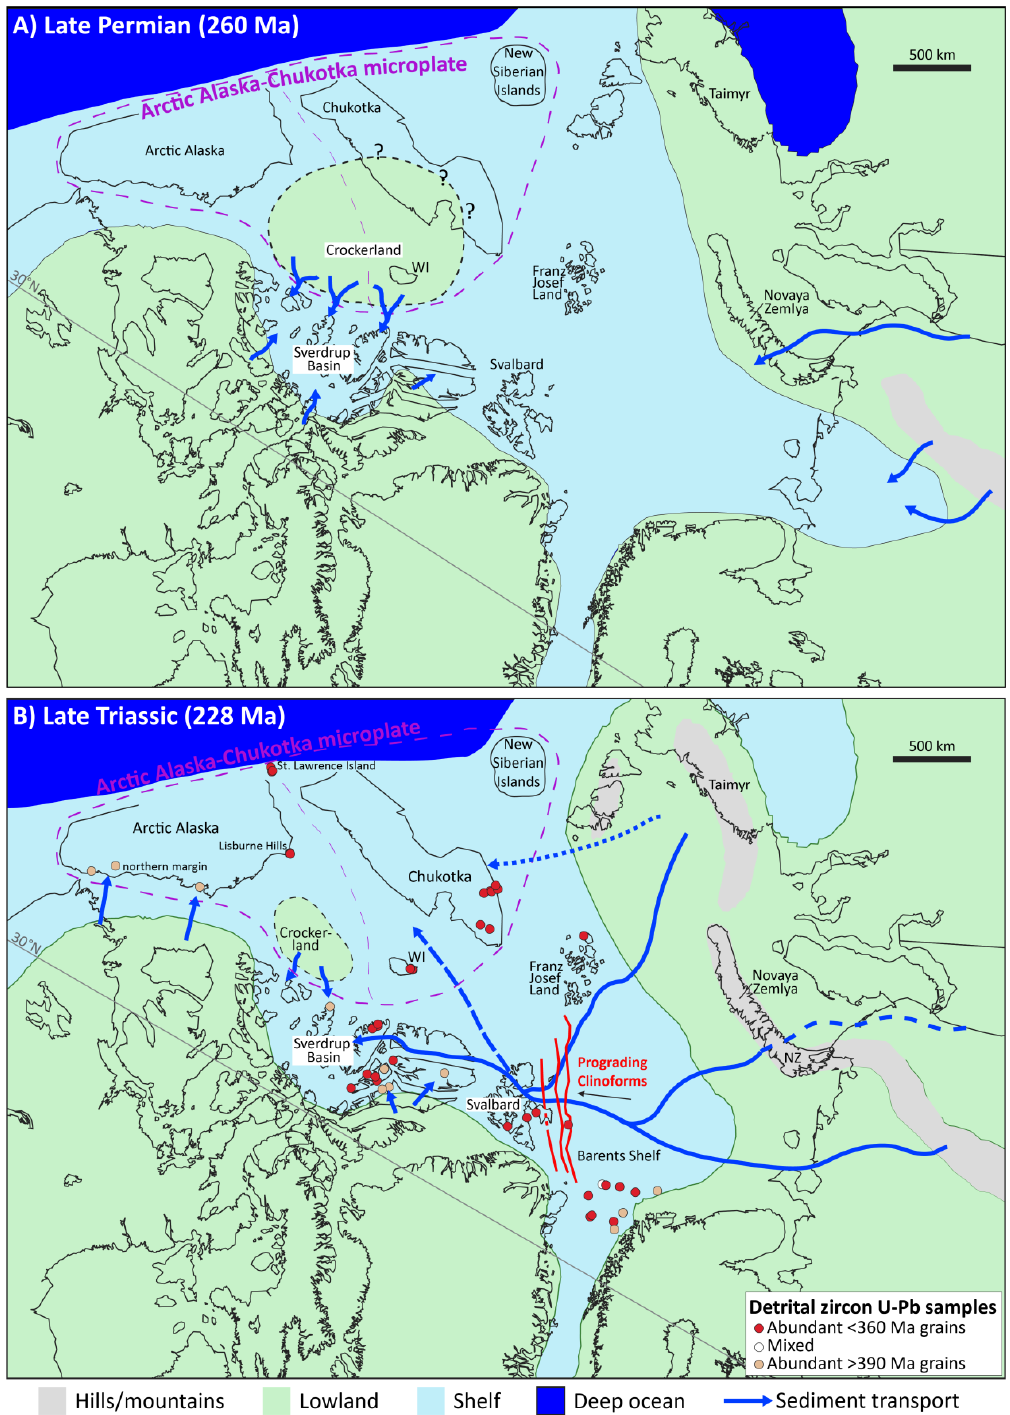
Figure 14. Simplistic regional palaeogeographic reconstructions of the Arctic region during: ( B ) Late Permian; and ( A ) Late Triassic times. The maps are modified from GPlates [149]. The palaeogeography is heavily modified from Cao et al. [150] using information in Anfinson et al. [32], Kos’ko and Korago [151], Miller et al. [7,8] and Tuchkova et al. [152]. The prograding clinoforms in ( B ) are redrawn from Gilmullina et al. [147]. Coloured circles represent new and literature samples within detrital zircon U–Pb age data. The sources of literature samples are given in Figure 15. Samples were classified into two main types (abundant <360 Ma detrital zircons and abundant >390 Ma detrital zircons) using dissimilarity analysis (Figure 16). WI = Wrangel Island.